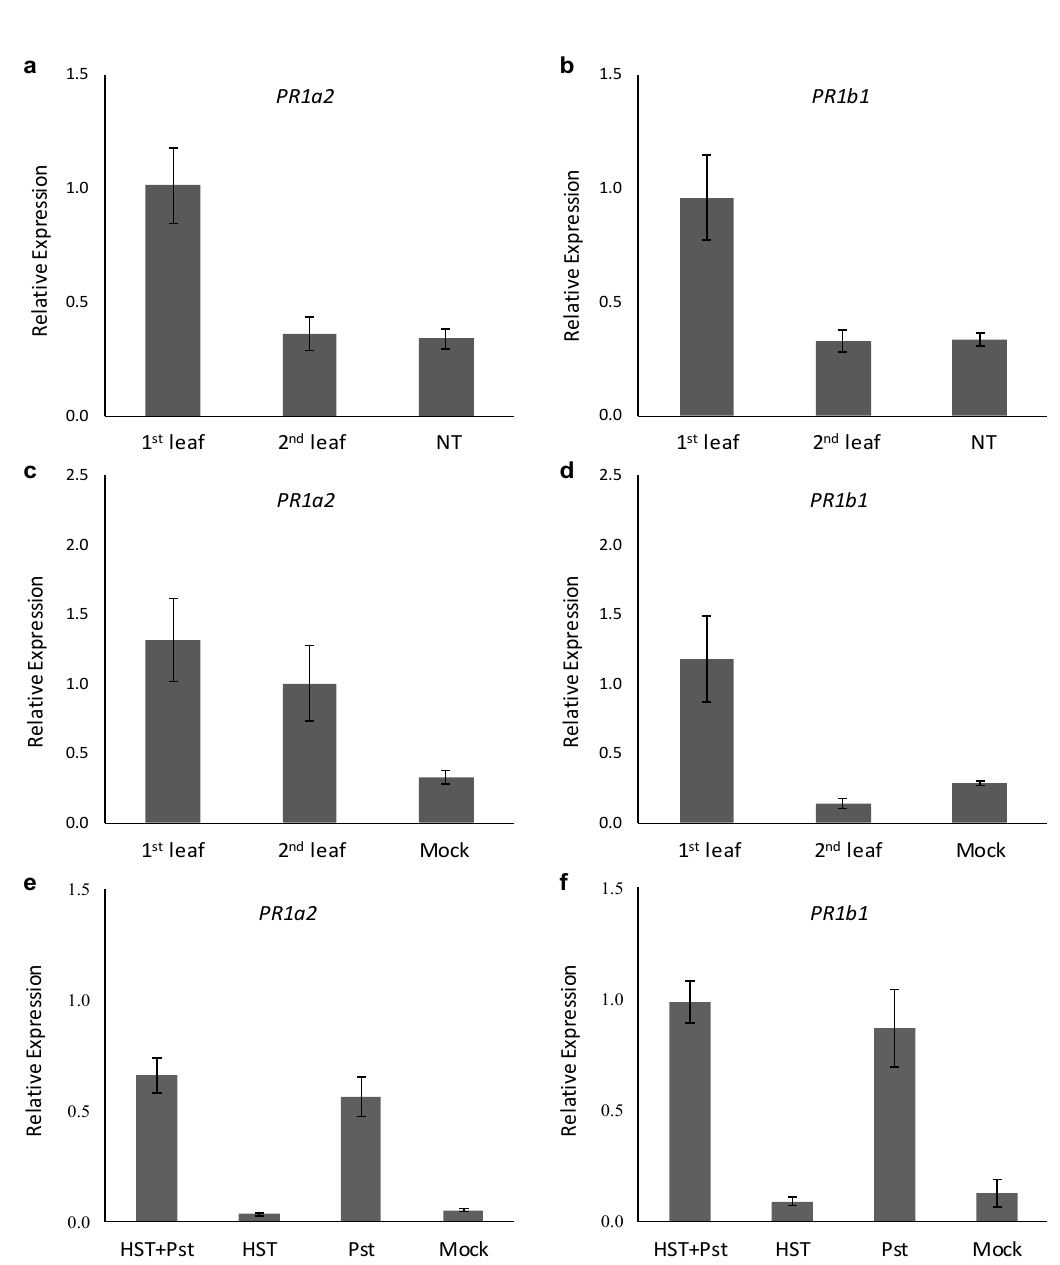
Figure 3. Relative expression levels of PR1a2 and PR1b1 in the leaves of the tomato cultivar Natsunokoma after partial treatment by HS, Pst inoculation or combined HS + Pst inoculation. Only the first leaf was subjected to HST at 45 °C for 2 min ( a , b ) or dipped into Pst solution ( c , d ). Thereafter, total RNA from the first and second leaf was extracted at 24 h after HST or Pst inoculation. In combined treatment ( e , f ), Pst was inoculated at 24 h after HST. Total RNA from the first leaf was extracted at 48 h after Pst inoculation, which was 72 h after HST. Gene-expression levels were quantified by qPCR and normalized to GAPDH expression. Vertical bars indicate the standard error of the mean ( n = 6).